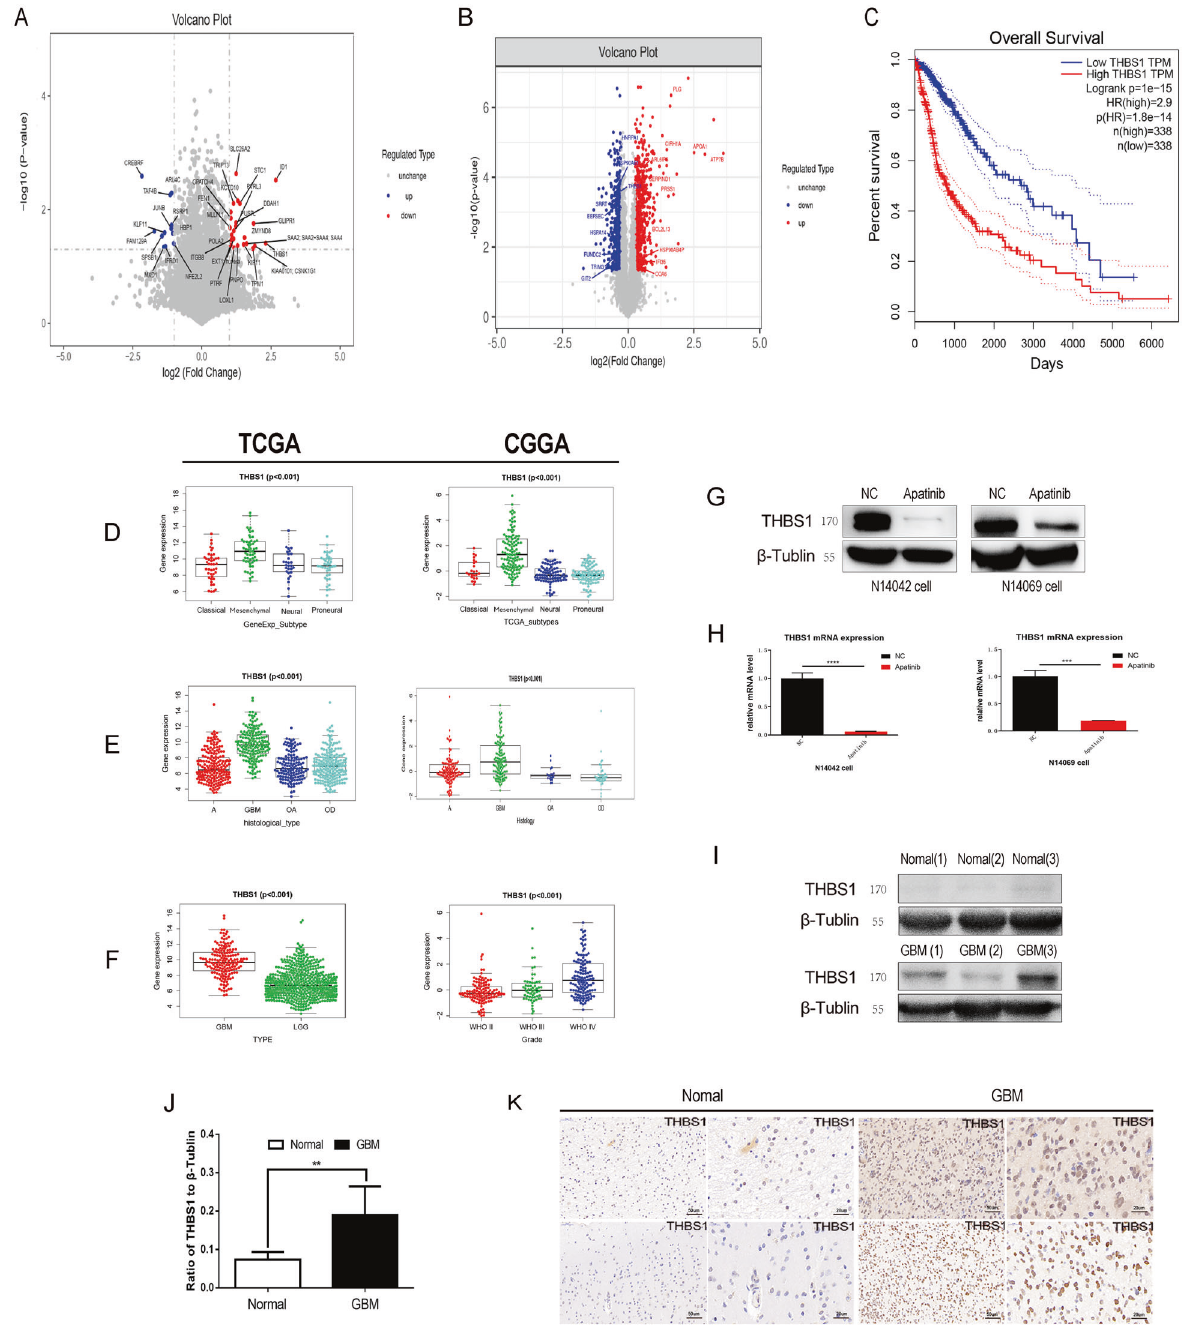
Fig. 3 Apatinib may inhibit the expression of thrombospondin 1 (THBS1) in gliomas. THBS1 mRNA is inversely correlated with overall survival (OS) in patients with glioma and relates to glioma histology and the glioblastoma (GBM) subtype. A Volcano plot of differentially expressed genes in N14042 and N14069 glioma cells after apatinib treatment (1vs1). The downregulated genes common in both cell lines were analyzed. B Volcano plot of differentially expressed proteins in the two cell lines that have been mixed and processed (3vs3). The downregulated proteins were analyzed and overlapped with the RNA-seq data. C The Cancer Genome Atlas (TCGA) equation data sets were used for survival analysis for high-level/low-level THBS1 expression in glioma. D The expression features in GBM subtypes were examined using the TCGA and the Chinese Glioma Genome Atlas (CGGA) data sets. E , F TCGA-seq and CGGA-seq data sets were used to estimate the correlation between THBS1 mRNA expression and tumor grade according to the World Health Organization (WHO). E mRNA levels of different histological subtypes were examined: astrocytoma (A), oligoastrocytoma (OA), oligodendroglioma (OD), and GBM, with CGGA-seq and TCGA- seq data sets. G , H Protein and mRNA expression levels after apatinib treatment were detected by western blot and qPCR analyses. Data are shown as mean ± standard deviation (SD), n = 3, # p = NS, * p < 0.05, ** p < 0.01, *** p < 0.001, **** p < 0.0001, Student ’ s t test. I , J Protein expression levels of THBS1 in normal and tumor tissues were detected by western blotting. Data are shown as mean ± SD, n = 5, # p = NS, * p < 0.05, ** p < 0.01, *** p < 0.001, **** p < 0.0001, Student ’ s t test. K Immunohistochemistry (IHC) staining in normal and tumor